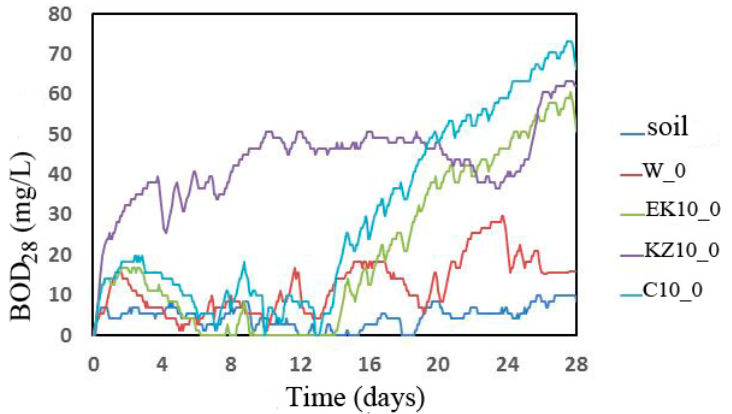
Figure 7. Dependence of BOD changes in time.